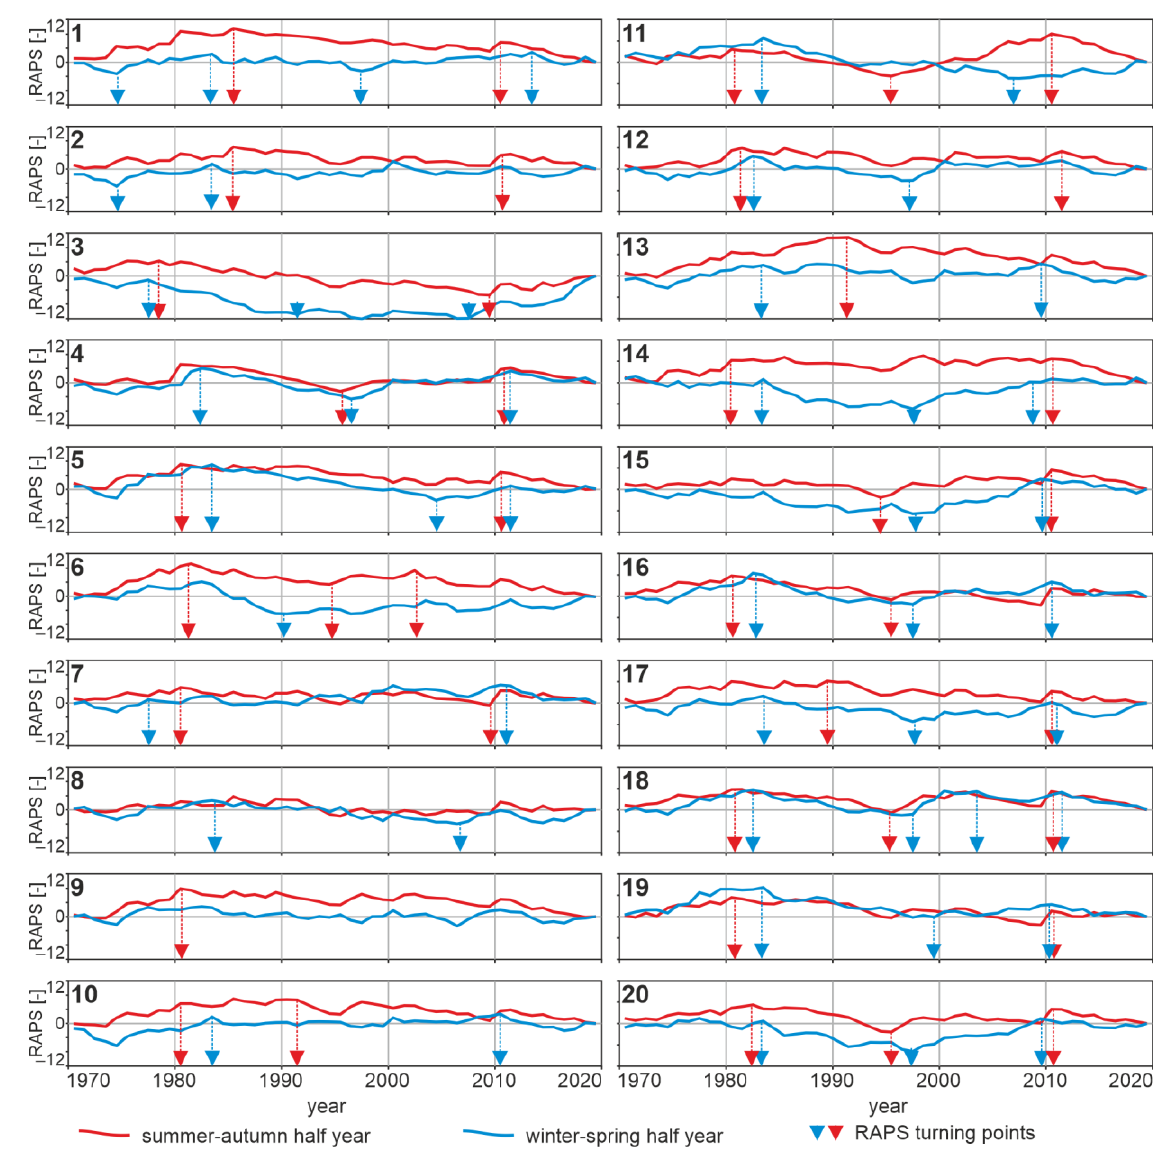
Figure 9. RAPS analyses of baseflow totals in the half years in 1970 – 2019. Numbers refer to catchment ID numbers provided in Table 1.